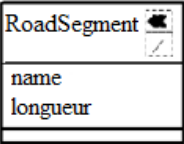
Figure 9. Example of fuzzy alternative geometry